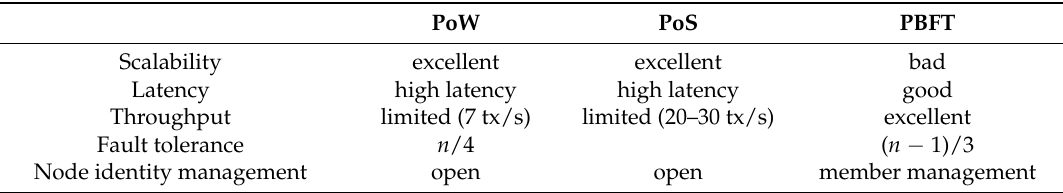
Table 1. Comparison of blockchain consensus protocols. PoS: Proof of State; PoW: Proof of Work; PBFT: Practical Byzantine